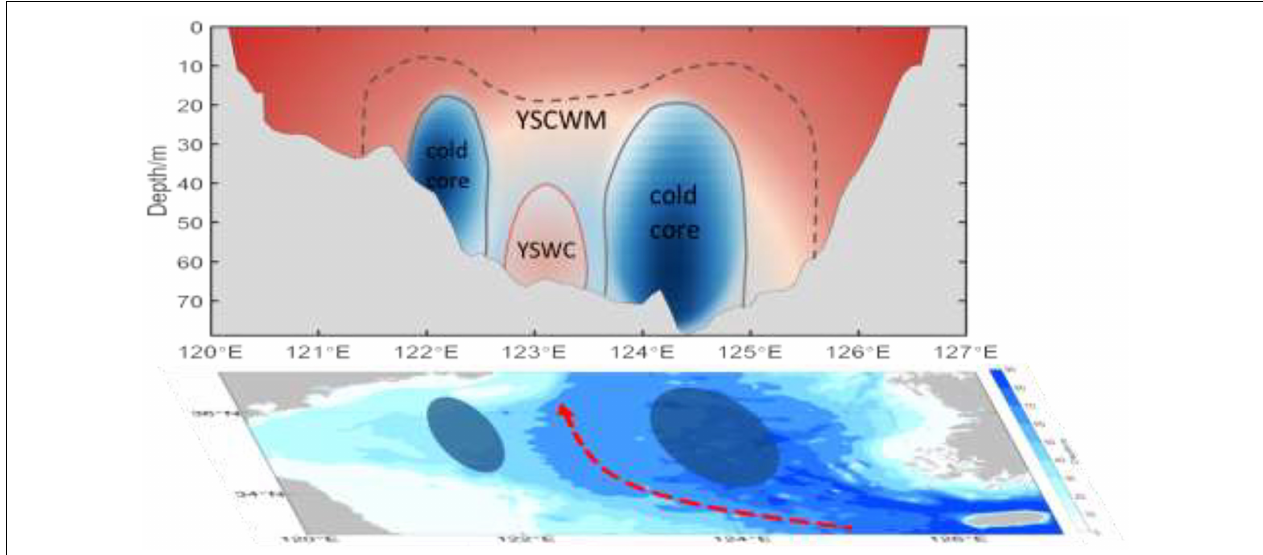
FIGURE 6 | Schematic structure of the YSCWM and YSWC in spring and autumn (the upper panel shows the section structures of the YSCWM and the lower panel shows the corresponding bottom